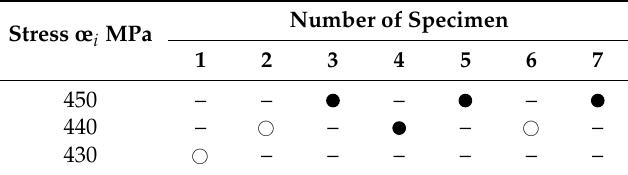
Table 3. Data for modified staircase method related to failed ( (cid:7) ) and not-failed (